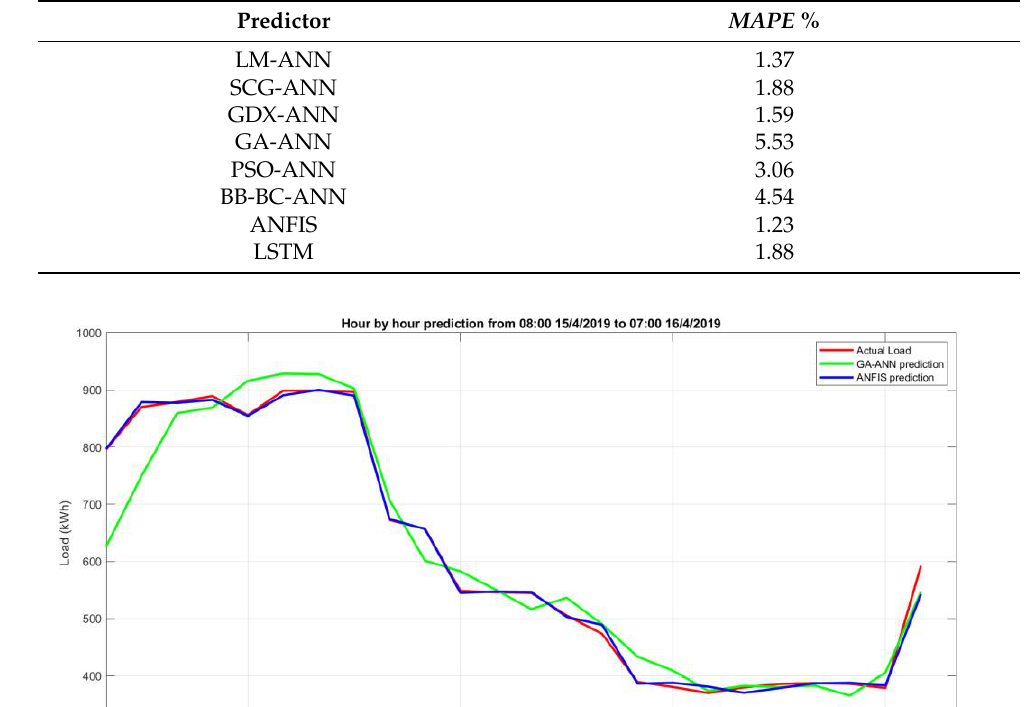
Table 4. MAPE results for a random day.